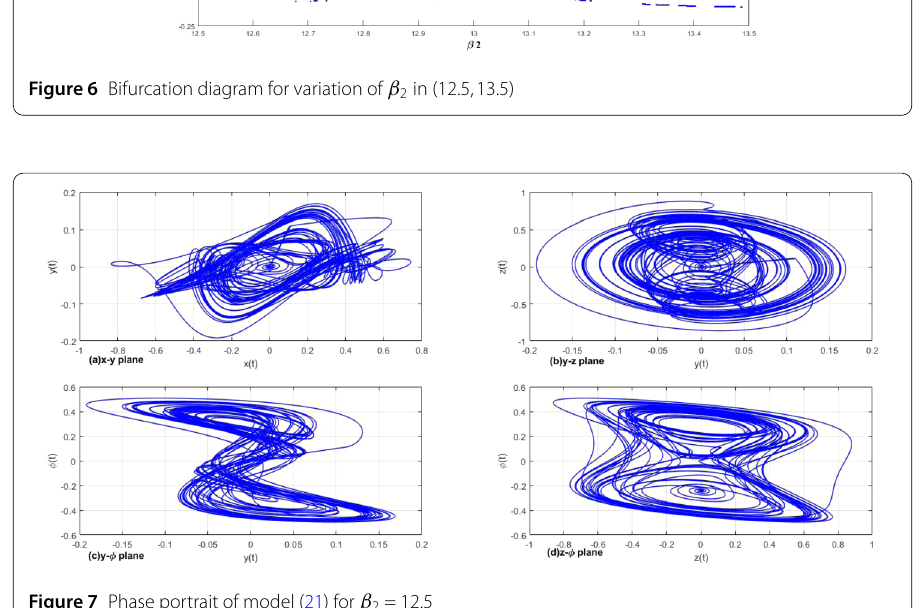
Figure 7 Phase portrait of model (21) for β 2 = 12.5